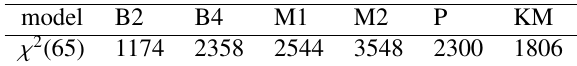
Table 1. Values of χ 2 (65) resulting from confrontation of selected chiral K − optical potentials with kaonic atoms data.